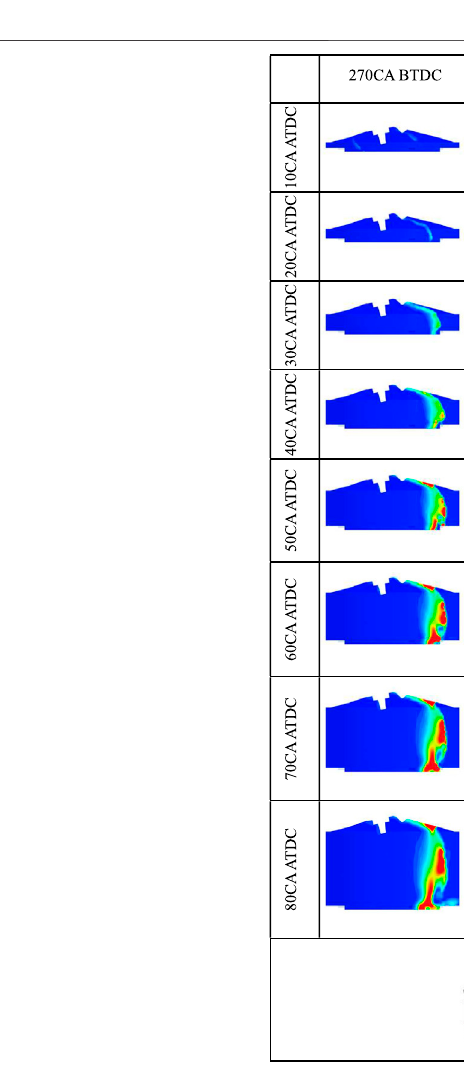
FIGURE 13 | Effect of injection timing on UHC